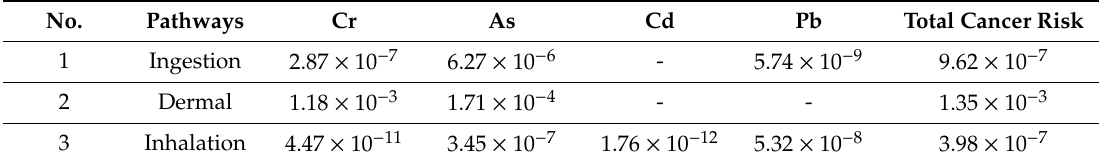
Table 12. Result of cancer risk for